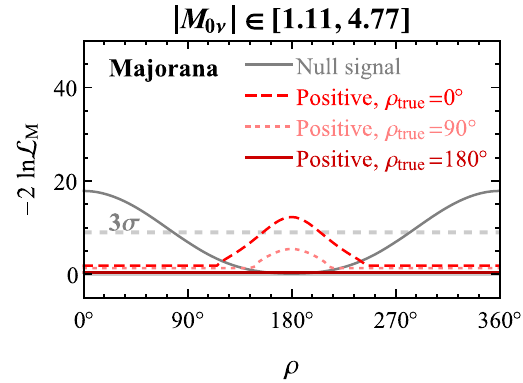
Fig. 4 The likelihood profile with respect to the Majorana CP phase (cid:2) (cid:2) (cid:2) M (cid:2) = 3 (left panel) or ρ , by assuming 0 ν panel) during the fit. Here, the experimental configuration is fixed as ξ = 20 ton · year and b = 1 ton − 1 · year − 1 . The observed number of